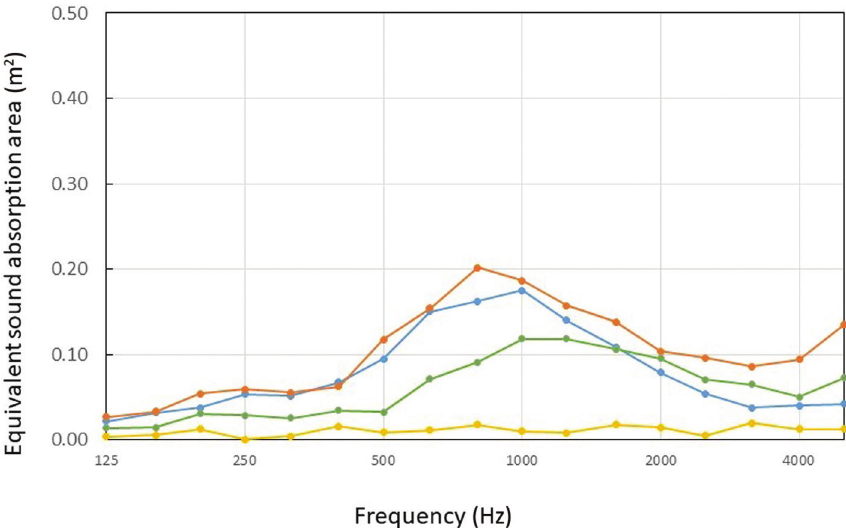
Application of transparent microperforated panels to acrylic partitions for desktop use